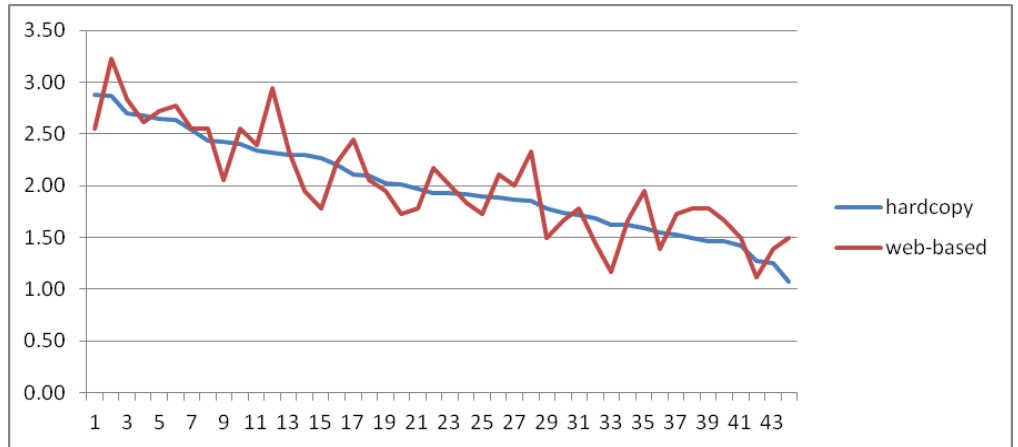
Figure 2 Comparison of hardcopy (n=116) and web-based (n=18) responses